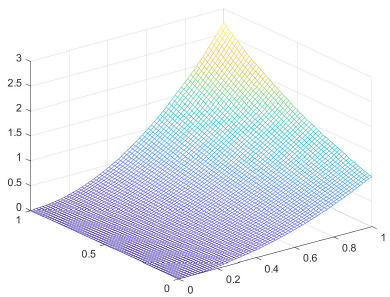
Figure 9. exact solution u = x 2 e y Figure 10. numerical solution u h of B.C. V Figure 9. Exact solution u = x 2 e y .